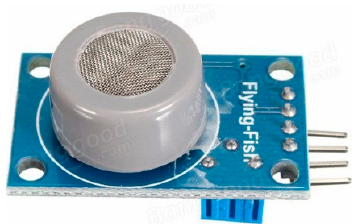
Figure 5. Smoke sensor used in the proposed system.